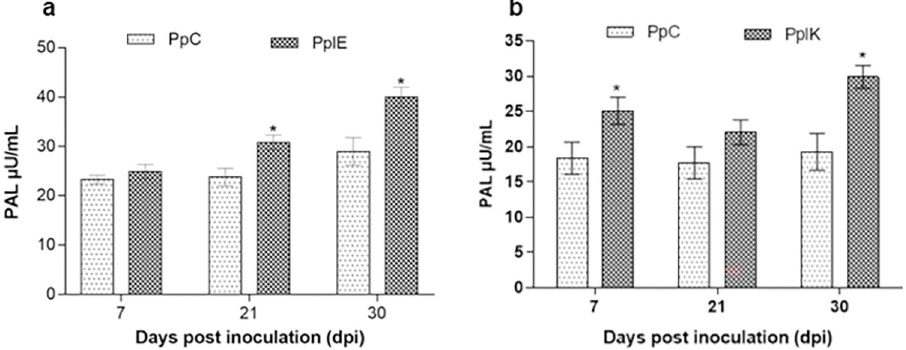
Fig 2. Variation in the PAL enzyme activity in plants inoculated (n = 3) with Enterobacter asburiae (A) and Klebsiella variicola (B). � Statistically different according to Bonferroni test ( p < 0.05). dpi : Days post inoculation. PpC : P . pellucida control. PpIE : P . pellucida inoculated with Enterobacter asburiae . PpIK : P . pellucida inoculated with Klebsiella variicola .